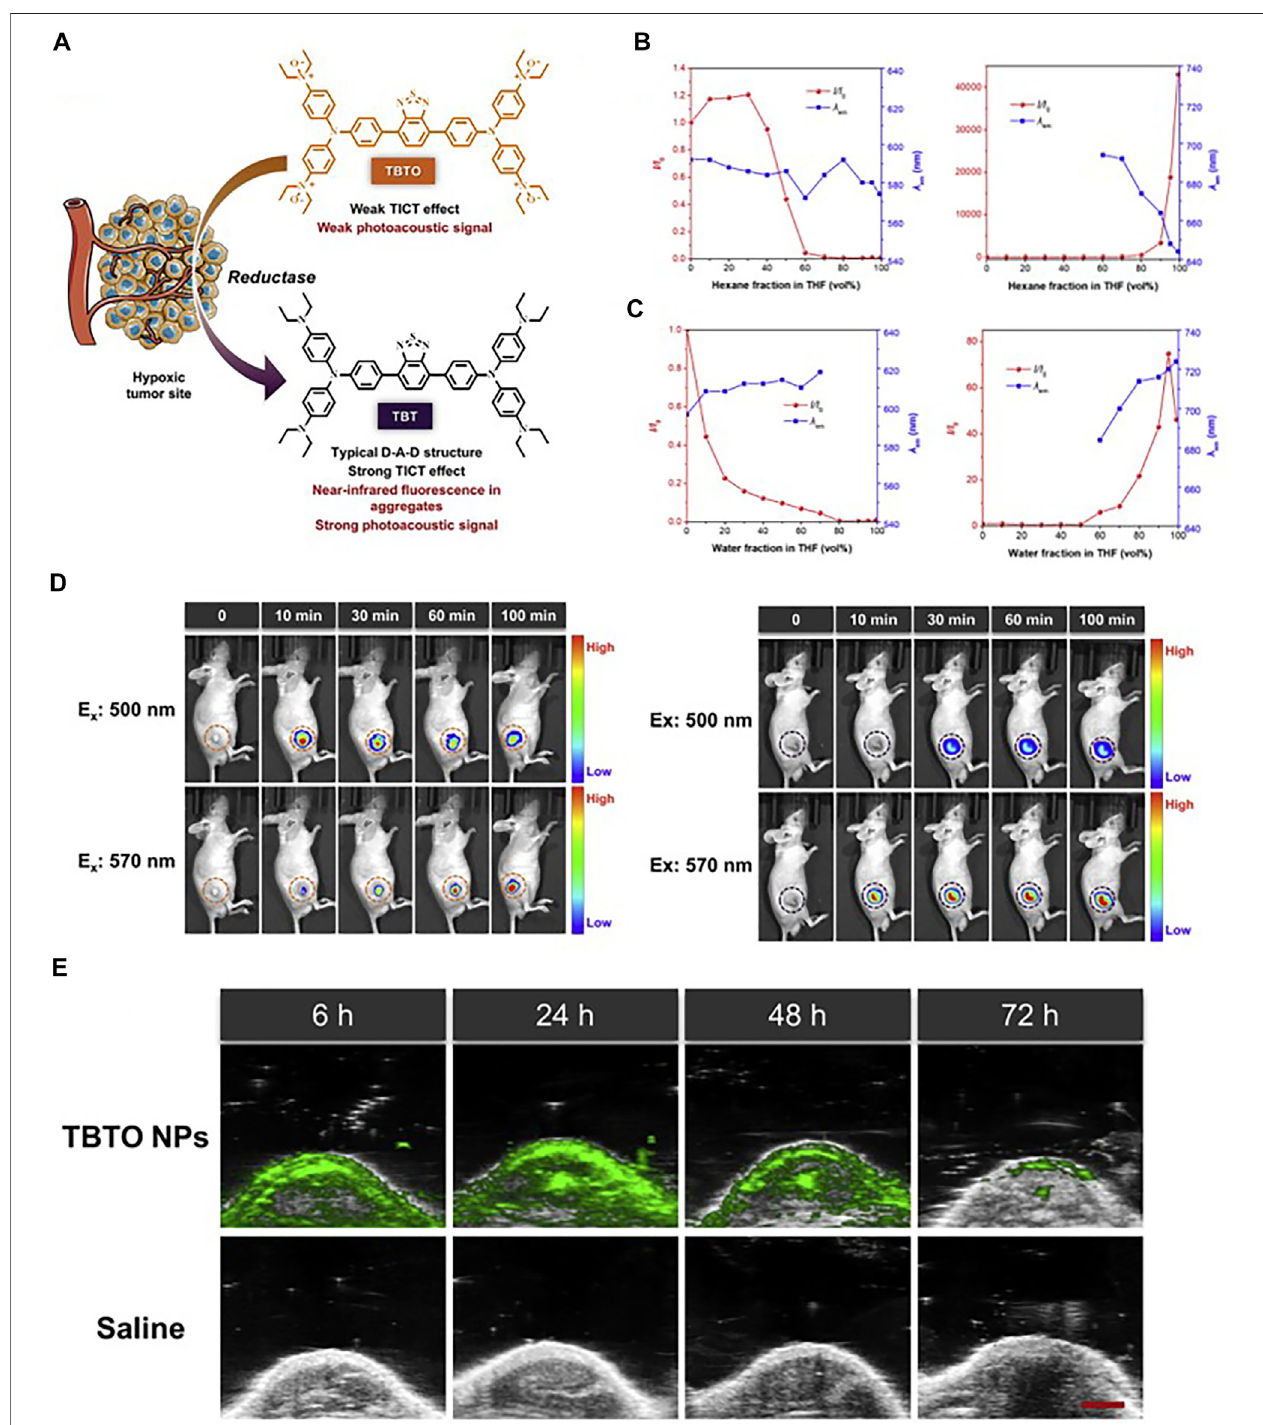
FIGURE 12 | (A) Schematic illustration of hypoxia-activated probe TBTO. (B) Fluorescence emission changes of TBTO (left) and TBT (right) in THF with different fractions of hexane. (C) Fluorescence emission changes of TBTO (left) and TBT (right) in THF with different fractions of water. (D) Time-lapse FI of mice before and after intra-tumoral injection with TBTO NPs (left) and TBT NPs (right). (E) In vivo PA images of the tumor site in the mice after tail intravenous injection with TBTO NPs (200 μ l, 1 mg/ml) or saline (200 μ l) as the control. Reproduced with permission from Li M. et al. (2021). Copyright 2021, Cell Press.